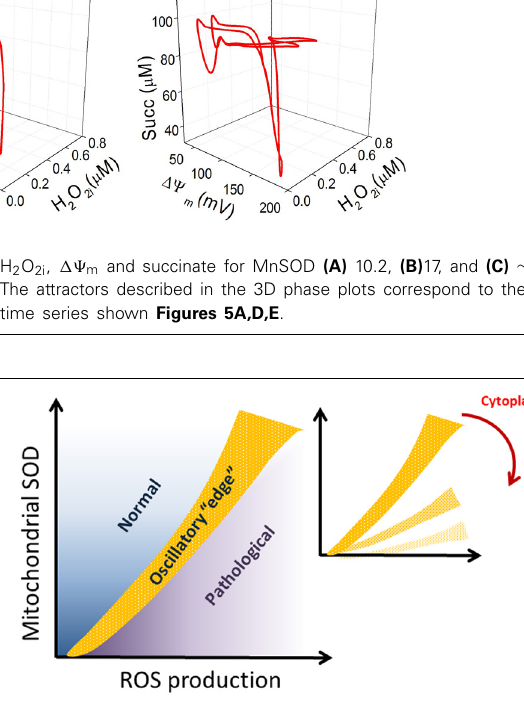
FIGURE 7 | Schematic representation of the dependence of mitochondrial dynamics on SODs compartmentalization. The domain delimiting normal from pathological mitochondrial function (represented in light brown) corresponds to the “edge” oscillatory region. The “edge” domain is characterized by the existence of complex oscillations. The inset shows how the “edge” is displaced toward the bottom of the graph as the antioxidant capacity given by CuZn SOD in the periplasmic-cytoplasmic (extra-mitochondrial) compartment increases. Red arrow and plus sign, indicate increasing concentrations of cytoplasmic